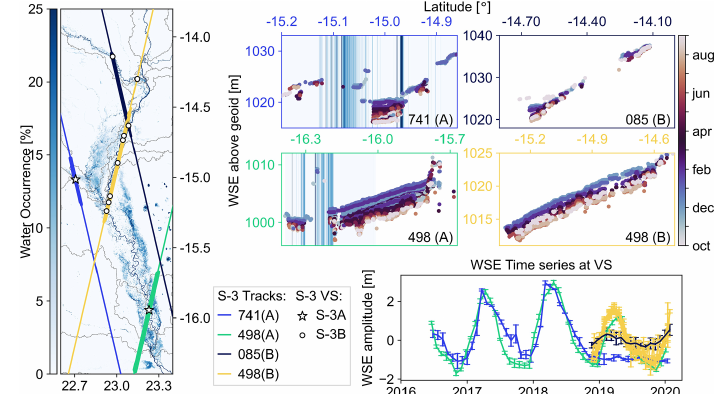
Figure 13. Floodplain dynamics in the Barotse floodplain as observed by Sentinel-3A (ground track 741 and 498) and Sentinel-3B (ground track 85 and 498). The water surface elevation (WSE) cross sections are in order of crossing tracks from west to east. The cyclical color scheme shows the WSE amplitude over the hydrological year. The line colors in the time series correspond to the track colors from the map and the width of the line indicates the observations shown in the scatter plots. The error bars reflect the standard deviation for each pass used in the time series. The water occurrence thresholds are deliberately set from to 0%–10% to enable the visualization of the floodplain.